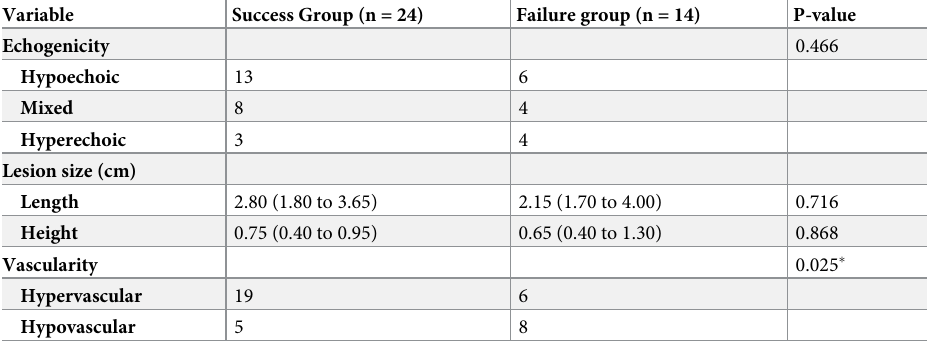
Table 3. Pre-treatment ultrasonographic imaging findings according to successful treatment. Variable